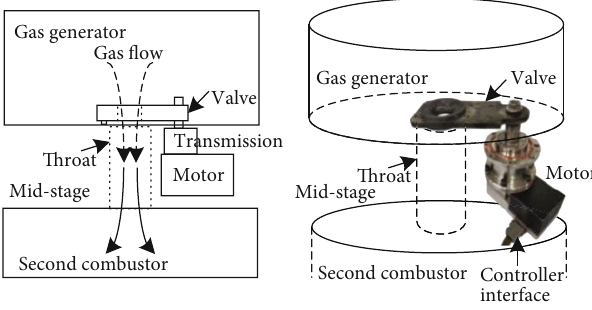
Figure 1: Schematics of the gas generator and the fl ow